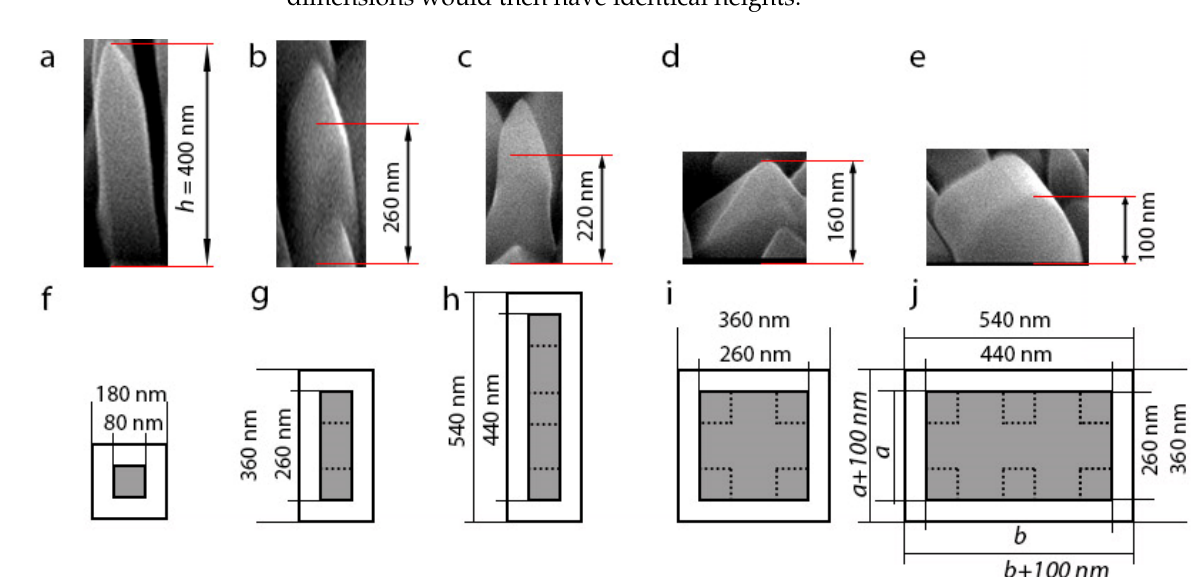
Figure 4. SEM images (side view) of the free-standing vertical VO 2 NWs (upper part of the figure) grown on silicon nanopillars with different cross-sectional areas; the diagrams are shown in the lower part of the figure. SEM image and cross-sectional area of single Si nanopillar with: ( a , f ) square section of 80 × 80 nm 2 ; ( b , g ) rectangular section of 80 × 180 nm 2 ; ( c , h ) rectangular section of 80 × 440 nm 2 ; ( d , i ) square section of 260 × 260 nm 2 , and ( e , j ) rectangular section of 260 × 440 nm 2 . In the schematic image, the gray area shows the surface of the silicon nanopillars on which the NWs grow; the light area around is the part of the substrate that was subject to etching during the formation of the periodic nanostructures and on which no crystal nucleation occurred.